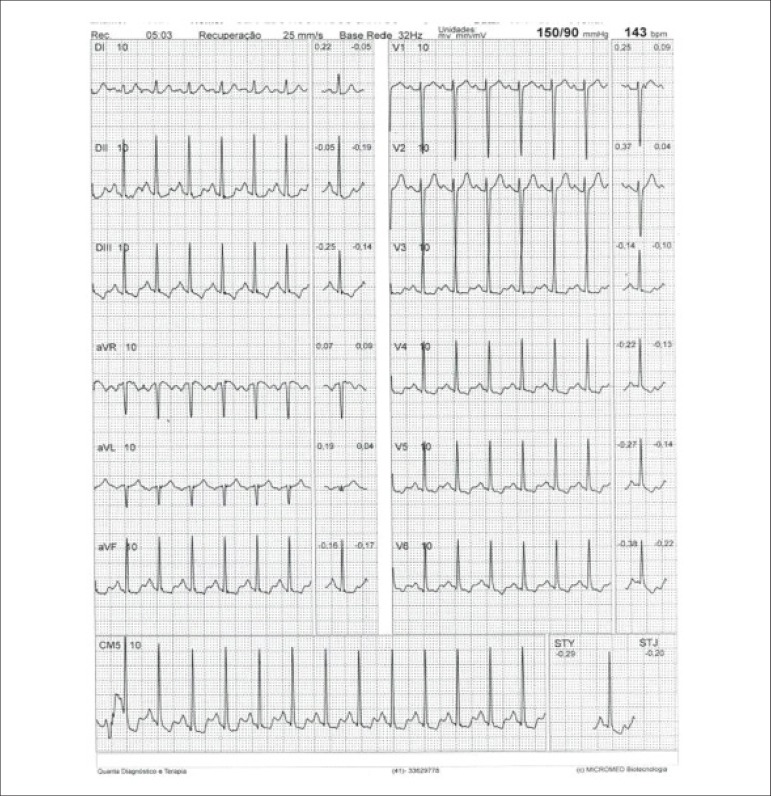
Case 6 - Electrocardiogram tracing showing electrocardiographic alterations (ST depression), especially during the recovery phase of the exercise c test.